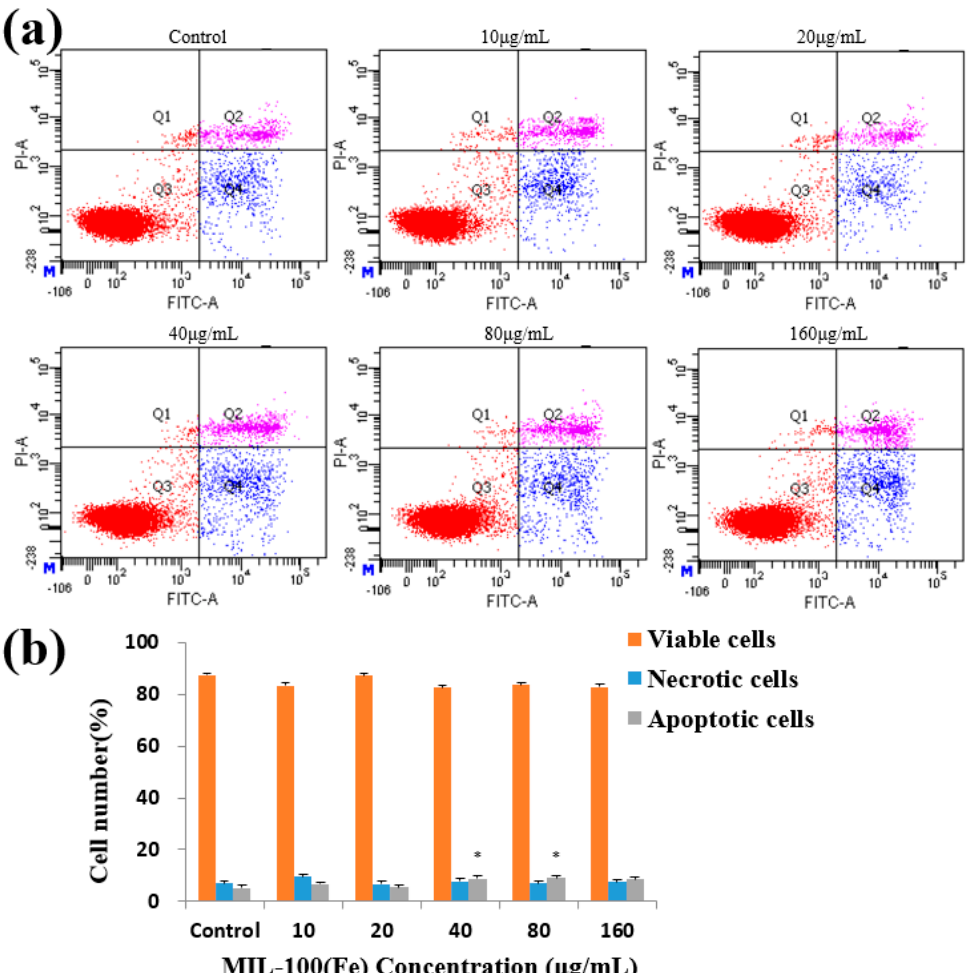
Figure 7. Effects of MIL-100(Fe) on apoptosis in HepG2 cells. ( a ) Flow cytometry detection of apoptosis with FITC-annexin V/PI double staining. ( b ) The percentages of viable, necrosis and apoptotic HepG2 cells after incubation with different concentrations of MIL-100(Fe) for 48 h. The data are expressed as means ± S.D. from three independent experiments. (* p < 0.05 vs. Control.)